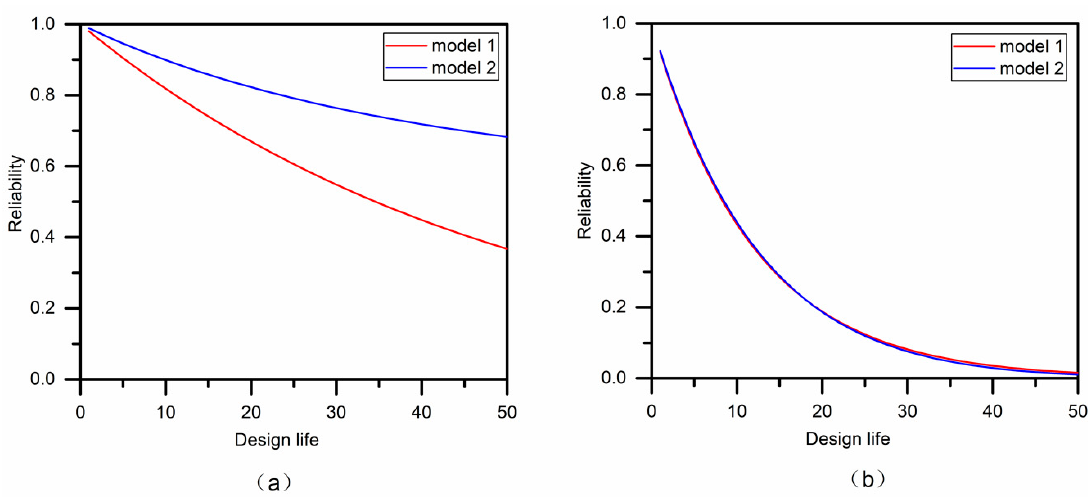
Figure 7. Reliability as a function of design life for ( a ) case AND, and ( b ) case OR.